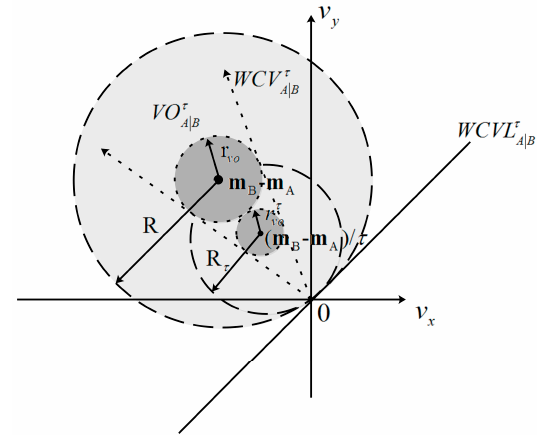
Figure 6. The geometrical expression of Corollary 1.